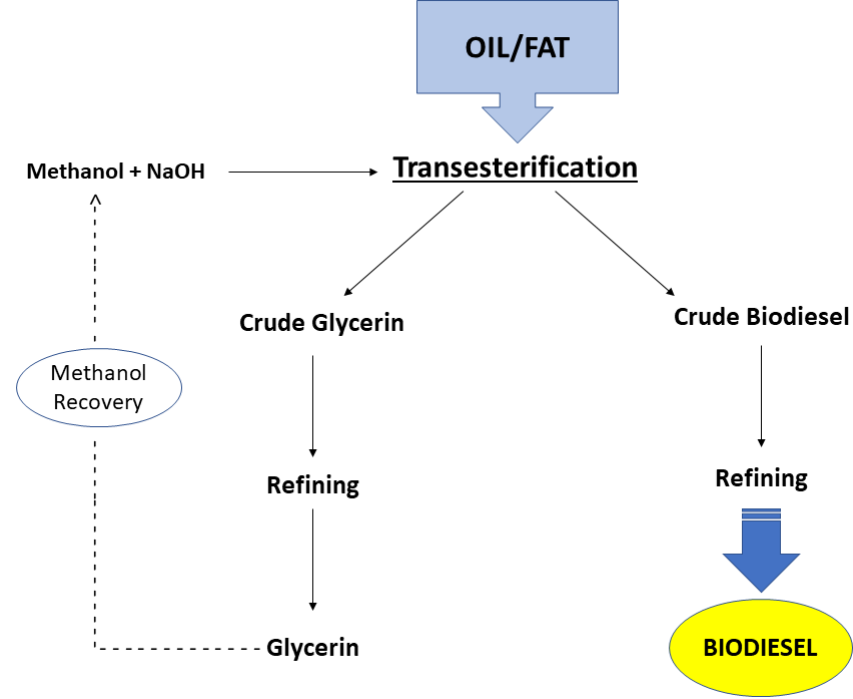
Figure 4. Biodiesel production pathway.